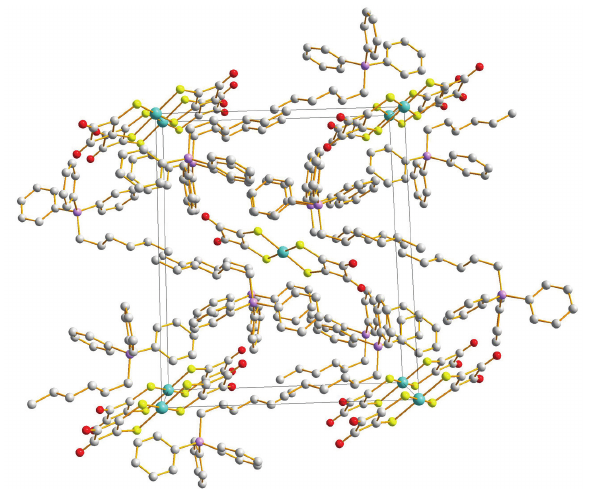
[ Ni(dtsq) ] (hydrogen P) 3 2 2